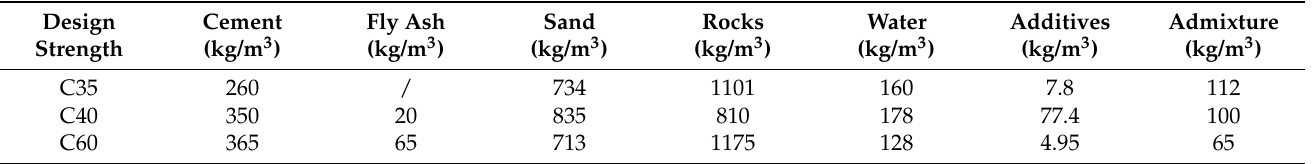
Figure 3. Material performance testing: ( a , b ) physical and mechanical properties test of concrete; and ( c ) material mechanical properties test of reinforcement. Table 1. Mixture ratio and type of